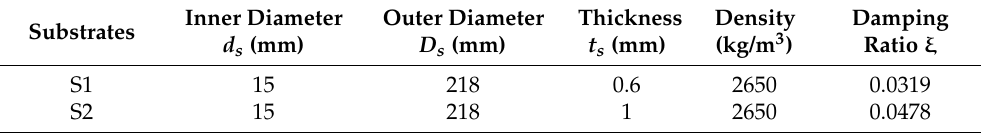
Table 1. Dimensions and Physical parameters of substrates.